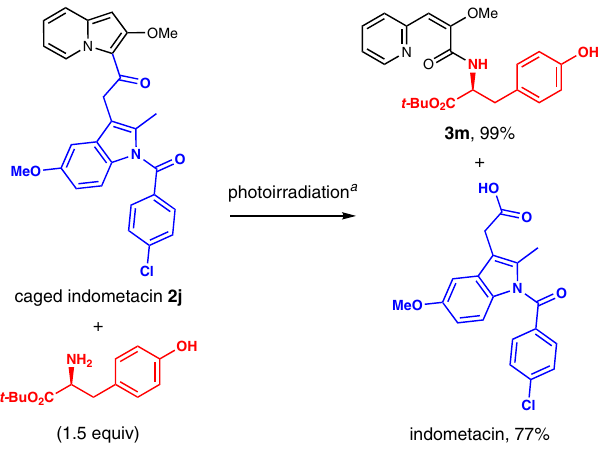
Fig. 5 Simultaneous conjugation and release of indometacin. Yields determined by high performance liquid chromatography (HPLC) measurements. a Red LED (660 nm), methylene blue (1 mol%), MeCN, under air, room temperature, 3